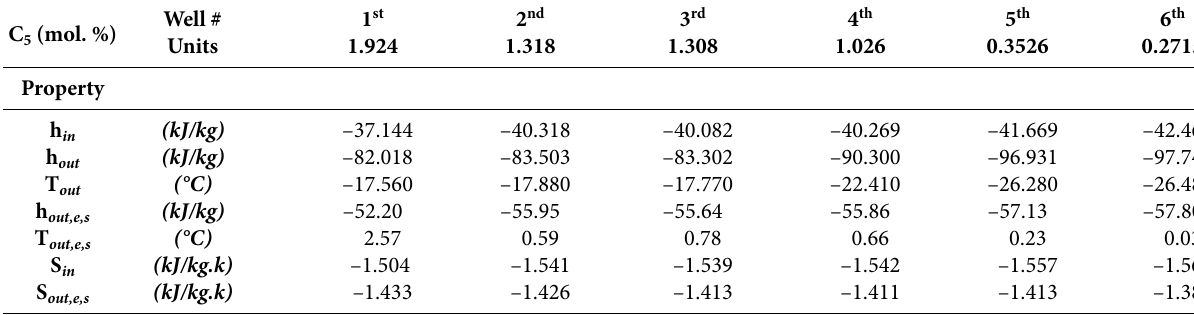
Table 4. Effect of Pentane concentration (C 5 %) variation on all properties C 5 (mol.